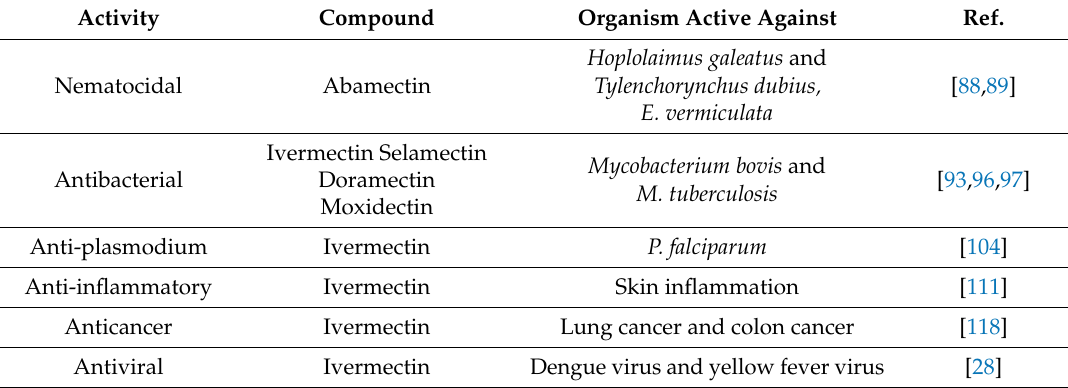
Table 3. Pharmacological activity of